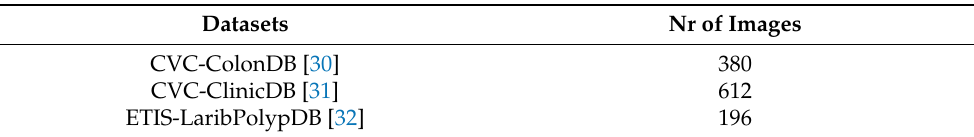
Table 2. Databases used to train and test the CNN-AE model.